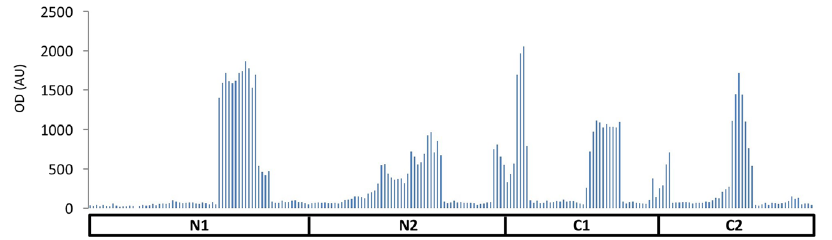
Figure 5. Antibody reactivity against IsaA epitopes measured by pepscan-ELISA. Bar chart with relative fluorescence signals as detected upon binding of α -IsaA polyclonal rabbit antibodies to 15-mer peptides with 14 residue overlap. The peptides are ordered on the x-axis according to the position of their N-terminal residue in the overall IsaA amino acid sequence. The relative positions of the IsaA fragments N1, N2, C1 and C2 are indicated. The y-axis shows the OD (in